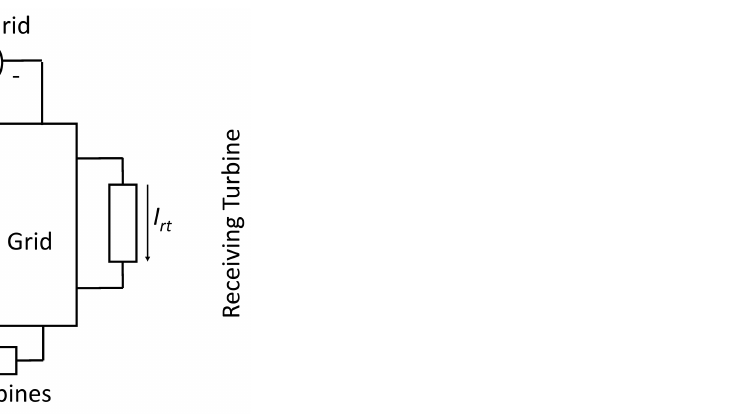
Figure A7. Multi-port representation representing transfer admittance from public grid to